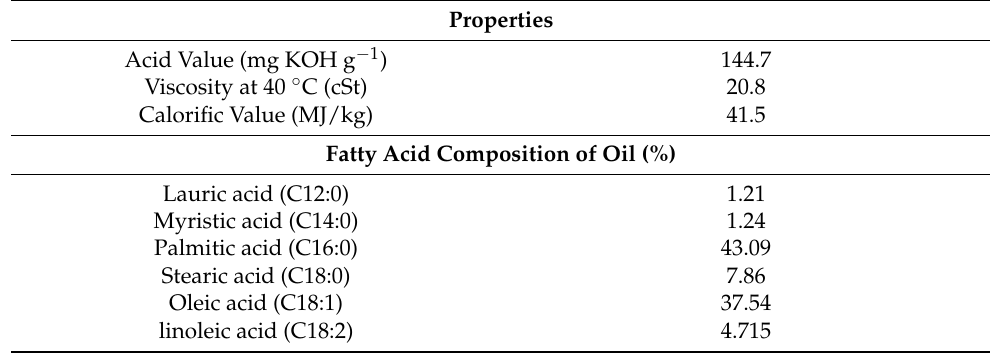
Table 2. Physicochemical properties and chemical composition of the